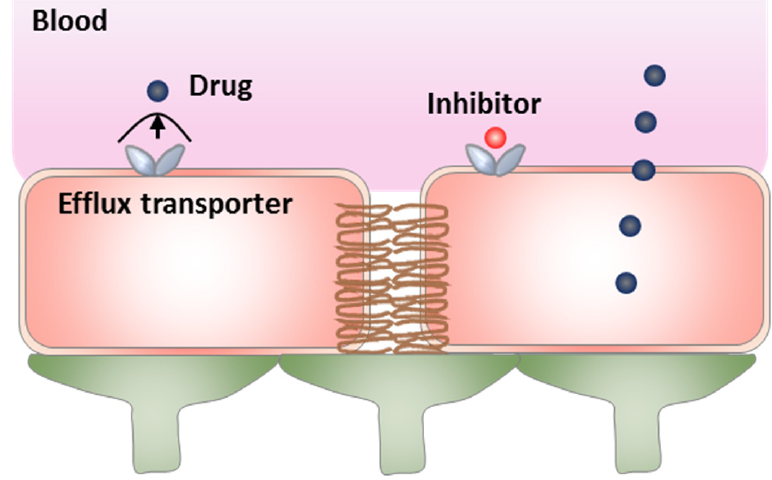
Figure 3. The strategy of directly inhibiting efflux transporters.